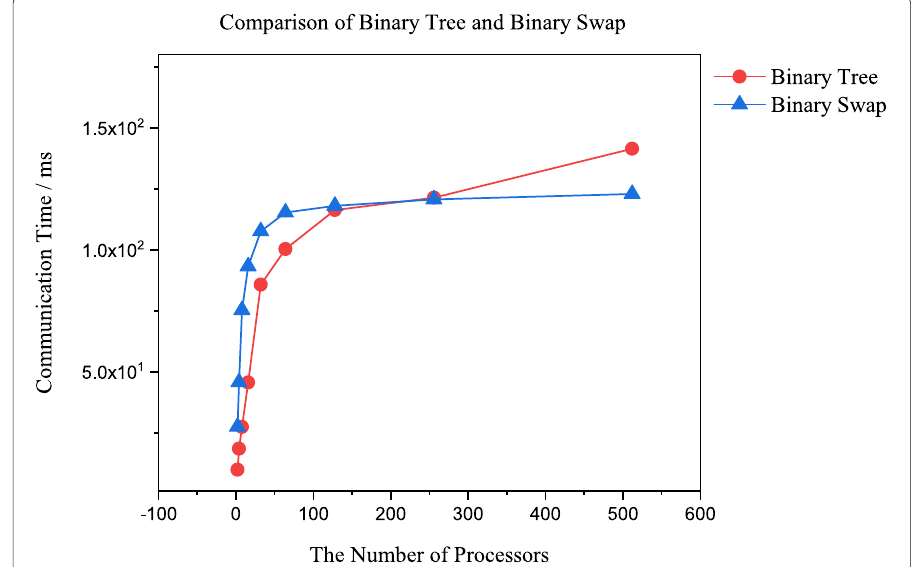
Fig. 4 Comparison of Binary Tree and Binary Swap. The cost of communication in Binary Tree is smaller than that in Binary Swap when the number of processors is smaller than 256